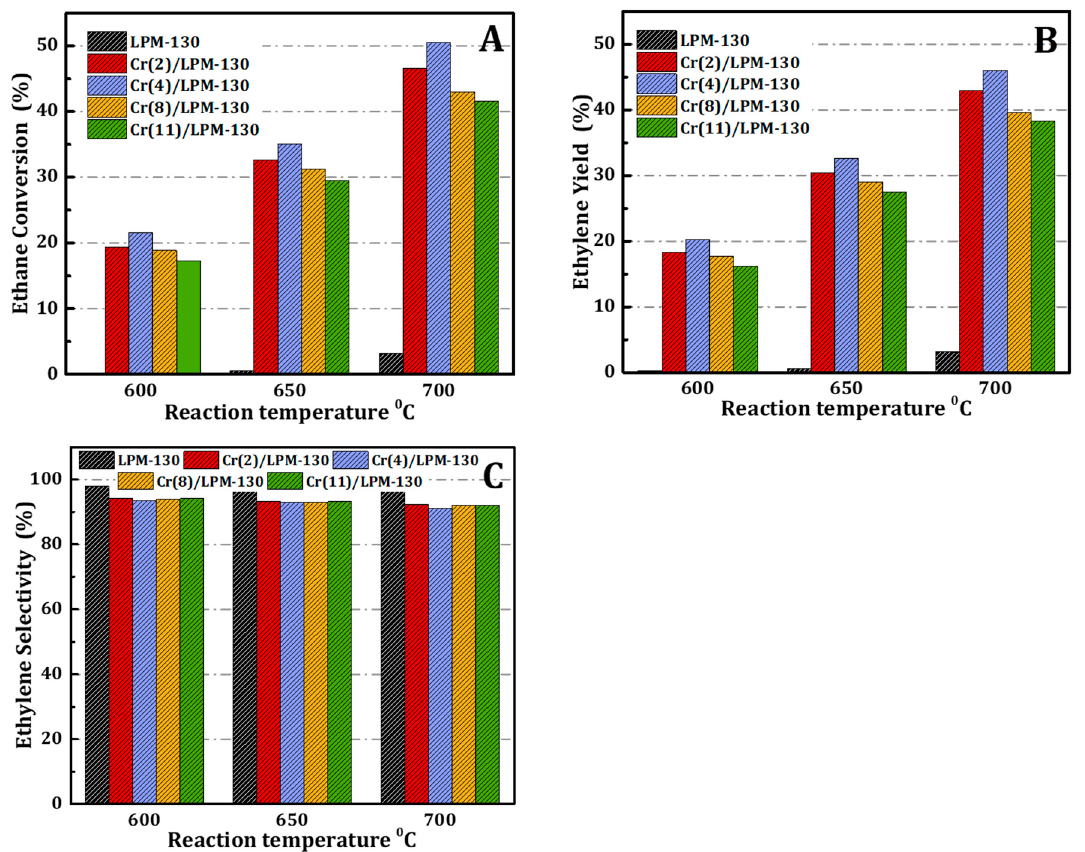
Figure 8. E ff ects of Cr loading on ( A ) C 2 H 6 conversion and ( B , C ) C 2 H 4 yield and selectivity, respectively, for Cr(y) / LPMS-130 catalysts at various reaction